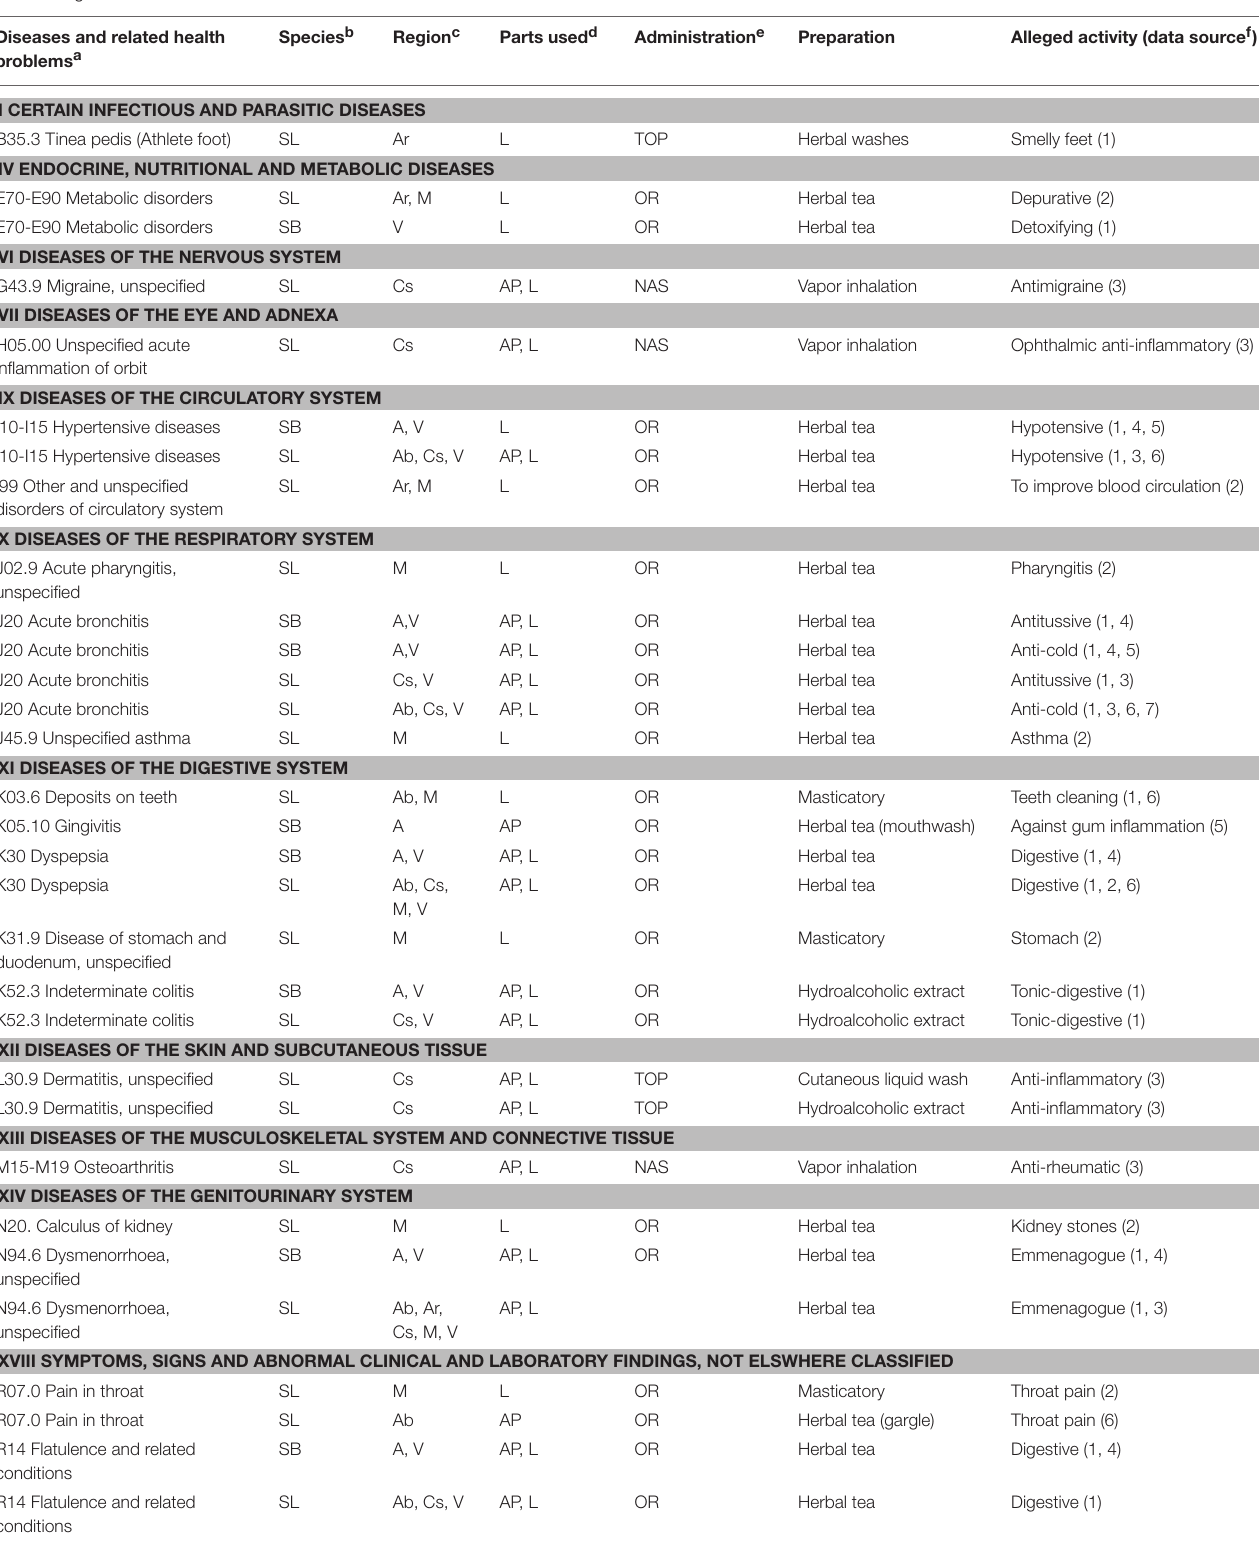
TABLE 2 | Ethnopharmacological evidence for medicinal uses for Salvia blancoana subsp. mariolensis and S. officinalis subsp. lavandulifolia in Valencia region and surrounding